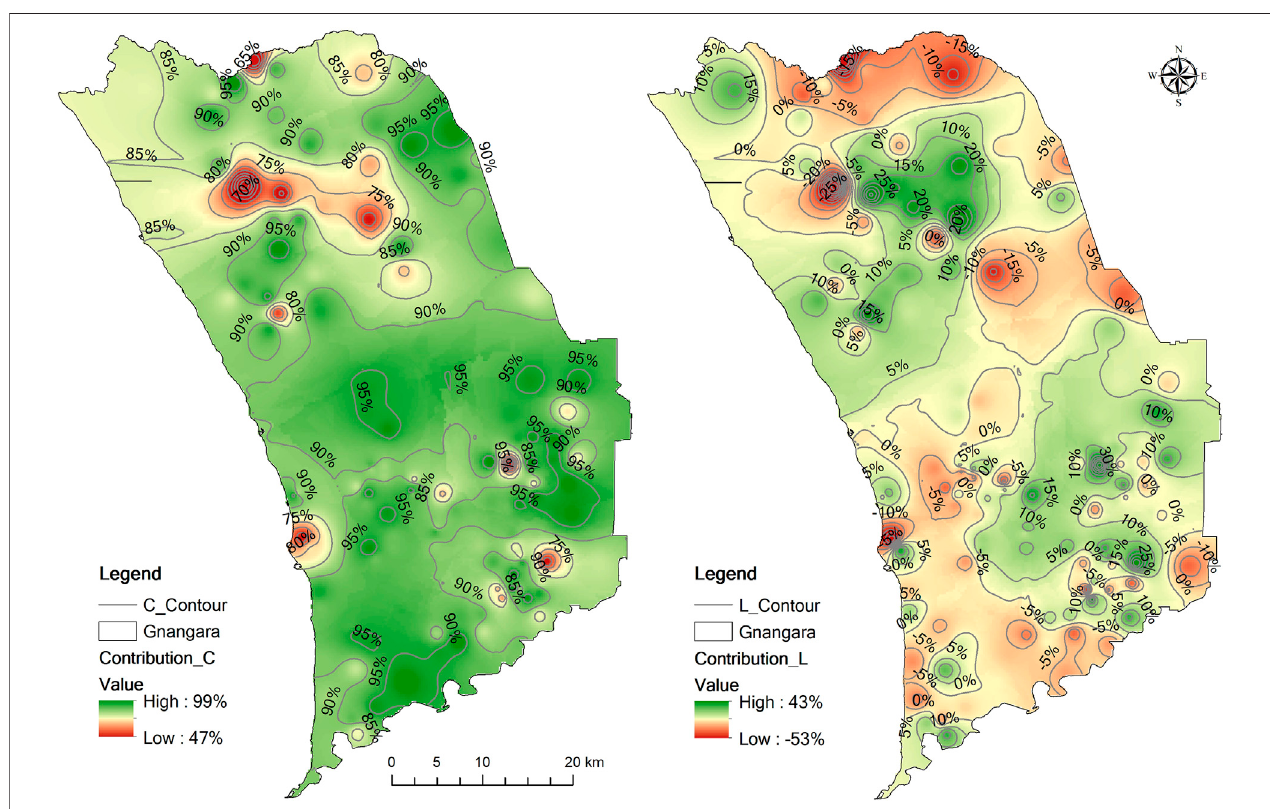
FIGURE 9 | Spatial distribution of the rainfall and land cover (as suggested by the NDVI) contributions to the groundwater level changes in the Gnangara region.